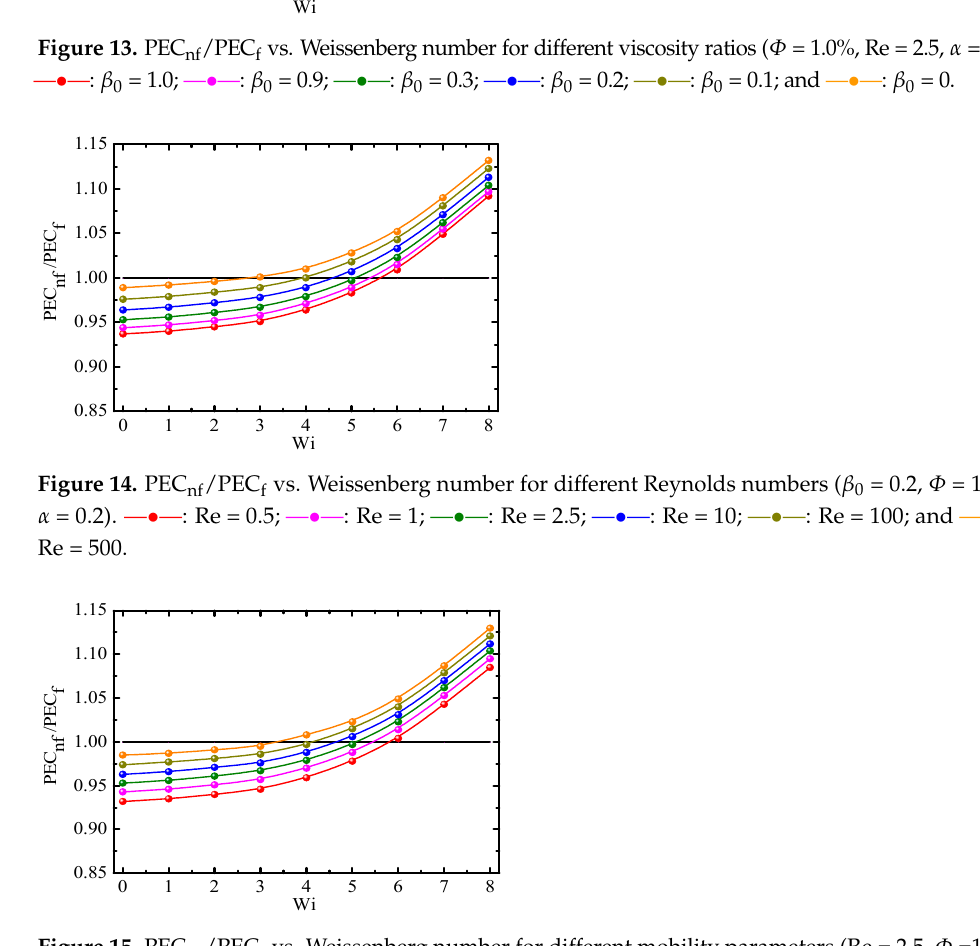
Figure 15. PEC nf /PEC f vs. Weissenberg number for different mobility parameters (Re = 2.5, Φ =1.0%, β 0 = 0.2). ⸺ ● ⸺ : α = 0; ⸺ ● ⸺ : α = 0.1; ⸺ ● ⸺ : α = 0.2; ⸺ ● ⸺ : α = 0.3; ⸺ ● ⸺ : α = 0.4; and ⸺ ● ⸺ : α = 0.5.